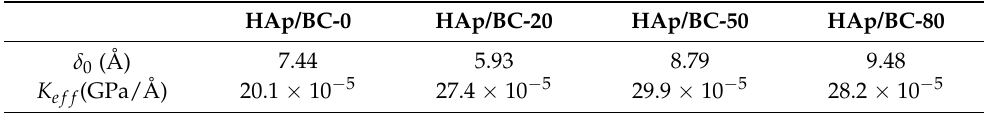
Figure 7. Traction-separation response of the HAp/BC bilayer models, for the sliding-mode test. ( a ) 45% and ( b ) 85% of the upper part of the BC was constrained during the moving of the HAp substrate. Table 4. Parameters of the system separation (i.e., 40% of the BC constraint), for the sliding-mode